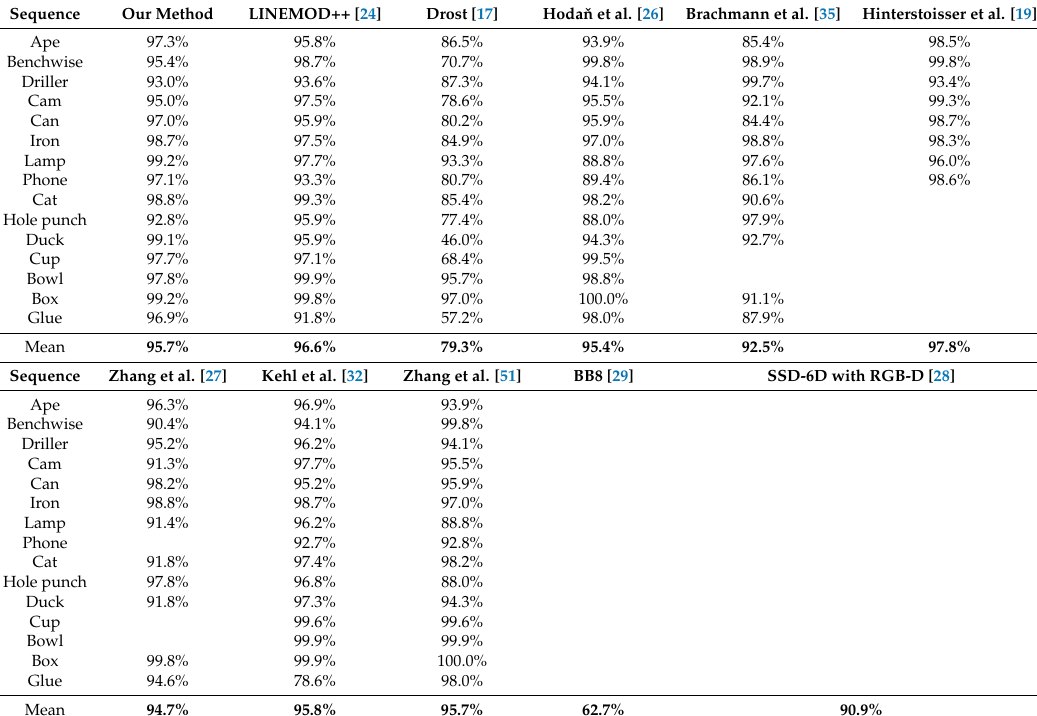
Table 1. Comparison of the results between different detection and pose estimation methods on the LINEMOD dataset [24] using the AD metric and k m = 0.1, given as the percentage of objects in which the pose was estimated with an error smaller than 10% of the object diameter.